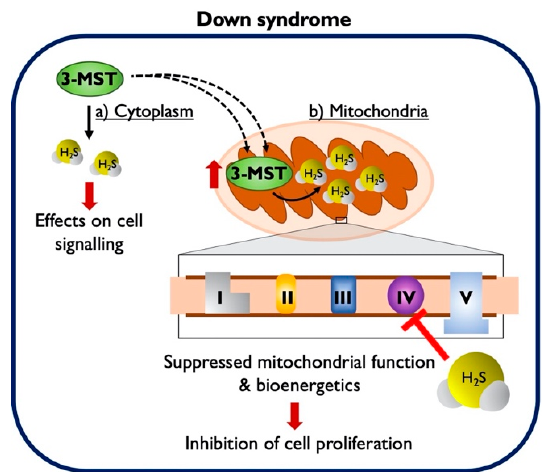
Figure 6. The 3-MST protein is upregulated in Down syndrome and contributes to cell dysfunction. The excess 3-MST is transported into the mitochondria. The subsequent overproduction of H 2 S suppresses mitochondrial electron transport and causes a cellular bioenergetic deficit, which is evidenced, amongst other responses, by a suppression of the cellular proliferation rate. Pharmacological inhibition of 3-MST with HMPSNE (not shown in this scheme) corrects H 2 S overproduction and improves bioenergetic parameters, resulting in the stimulation of Down syndrome cell proliferation.